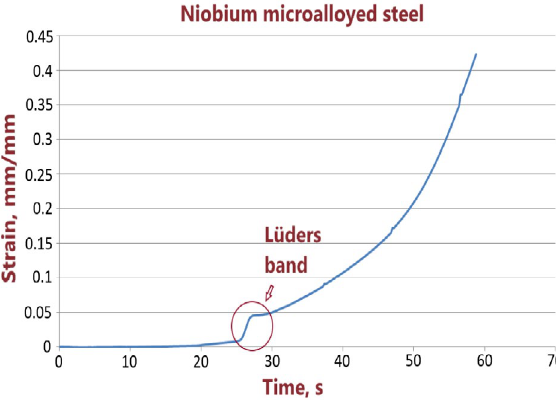
Figure 3. Quantitative analysis of the Lüders